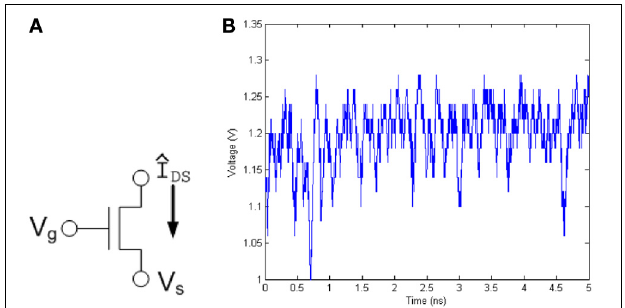
FIGURE 1 | (A) The noise characteristics generated by a single transistor can be used as well-defined noise source. The current through and thus the voltage at the drain or source node of the transistor produces noise due to the thermal agitation of charge carriers. (B) Voltage measured from a transistor on 0.35 µ m test